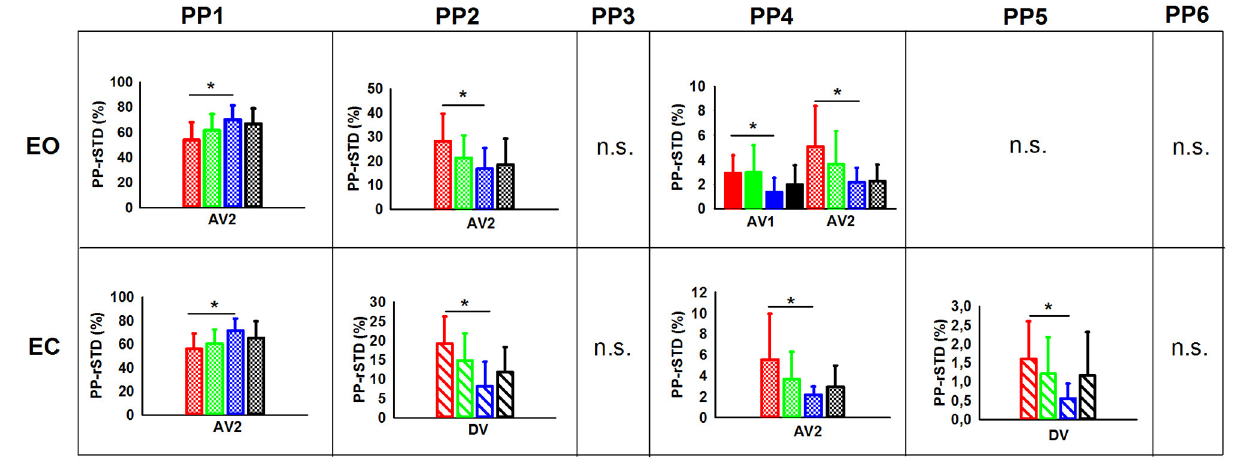
(i.e., PM 1 and PM 3 , respectively). The so-called ankle and hip strategies mentioned in the literature, together, accounted approximately for an 80% of the movement variance. On the other hand, ankle movements in the medio-lateral direction (ML) (i.e., PM 2 ) represented 15% of the movement variance while the rest of the variance (i.e., 5%) was explained by trunk rotations (without or with head movements) (i.e., PM 4 and PM 5 ) and knee flexion-extension movements (i.e., PM 6